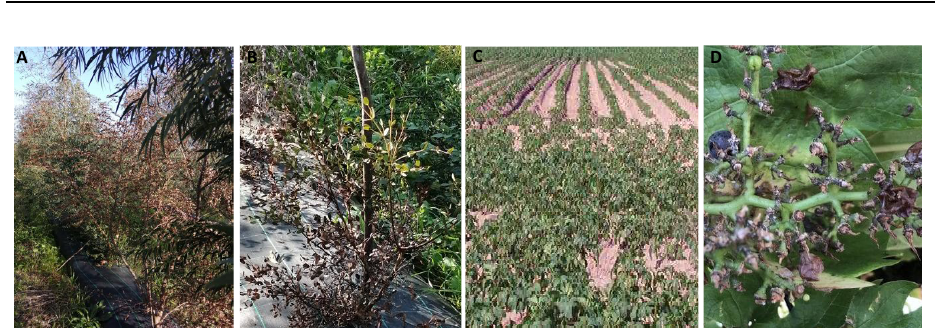
Figure 3 . Below-ground symptoms of Meloidogyne hapla attack (galls). ( A , B ): potato; ( C ): grape- vine. 3.3. Morphological Characterization